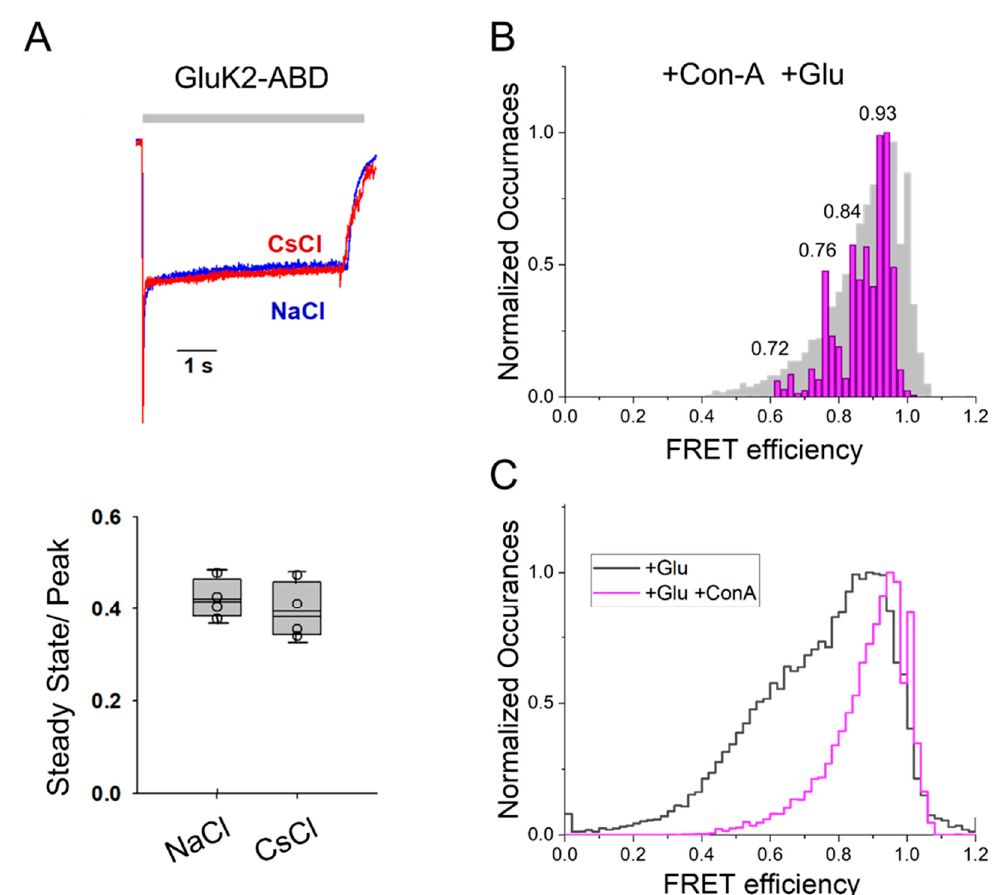
Figure 4. Effect of Con-A on ion modulation of GluK2 receptors. ( A ) Representative whole-cell recording with 1mM of glutamate and 40µM of Con-A for GluK2-ABD in the presence of either CsCl (red) or NaCl (blue) (top) along with the ratio of steady-state to peak currents obtained from at least three cells (bottom), showing no difference in steady-state response between NaCl- and CsCl-treated. ( B ) Denoised FRET efficiency histogram, in magenta, overlapped over the observed FRET efficiency histogram, in gray, depicting FRET efficiency occurrences in the presence of Con-A and glutamate obtained with CsCl replacing NaCl. ( C ) Comparison between observed FRET efficiency histograms of the homomeric, glutamate-bound, GluK2 receptor obtained with CsCl replacing NaCl, in the absence (in black) [34] and presence of Con-A (in magenta), illustrating a decrease in the low-FRET efficiency population in the presence of Con-A.